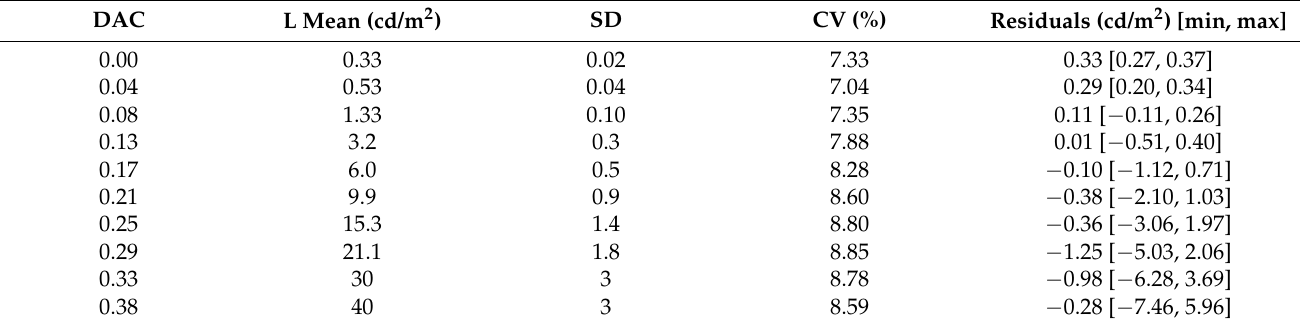
Figure 3. Luminance measurements from each device for the evaluated DAC values. A potential curve fit between DAC values and luminance L = α ∗ DAC γ was obtained in all cases. Table 1. Mean luminance (L mean), standard deviation (SD), coefficient of variation (CV) and the residuals for each DAC value.